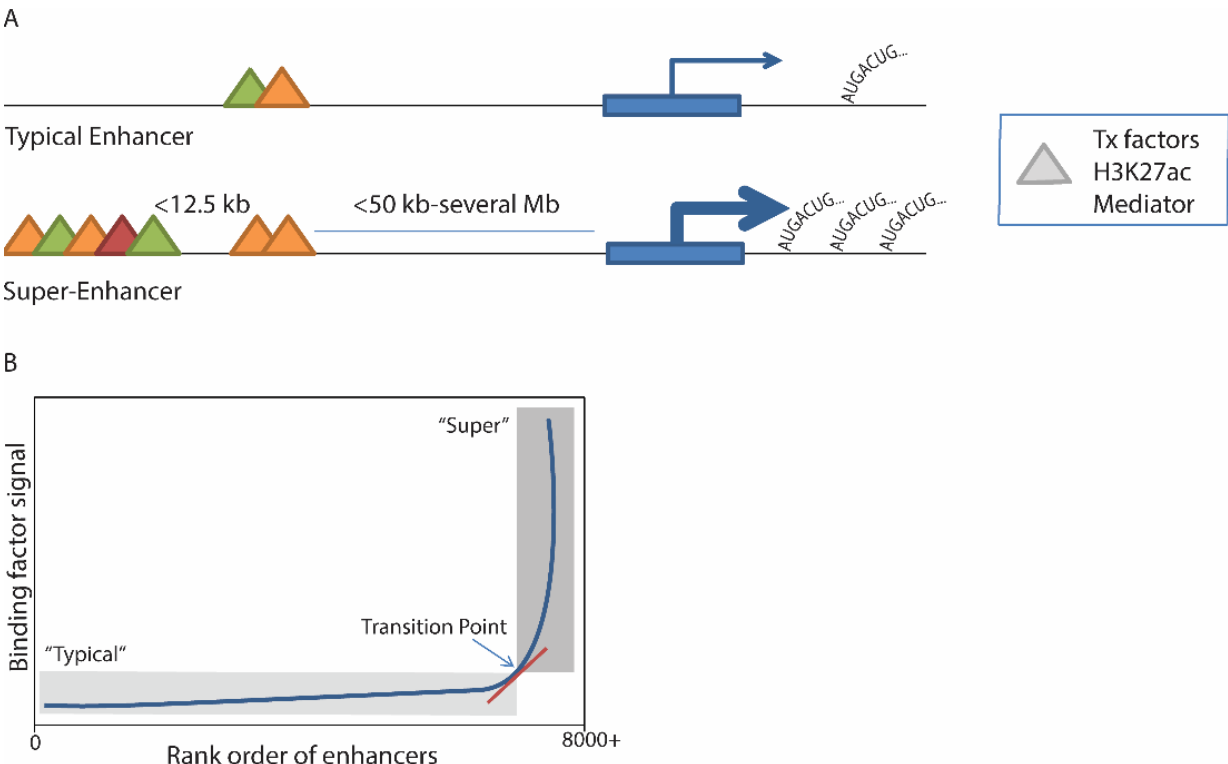
Figure 1. ( A ) Schematic representation of a typical enhancer and a super-enhancer. Definition of super-enhancers is based on identification of various bound transcription (Tx) factors, H3K27ac marks, or Mediator (triangles) and assembly of similar regions within 12.5 kb; ( B ) Distinction of enhancers from super-enhancers is accomplished by ranking